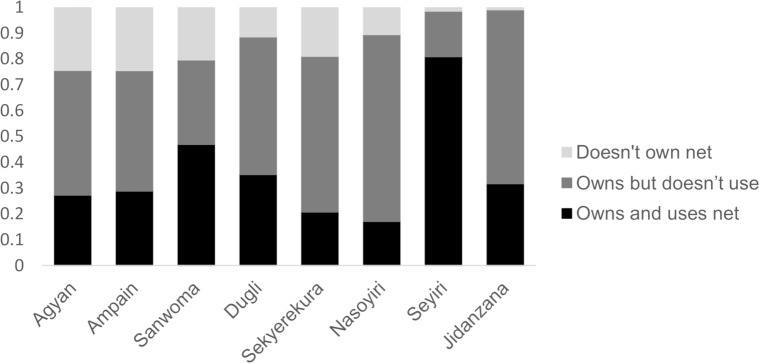
Bednet ownership and use by village.Participants were asked whether they owned a bednet and whether they slept under their net the previous night.